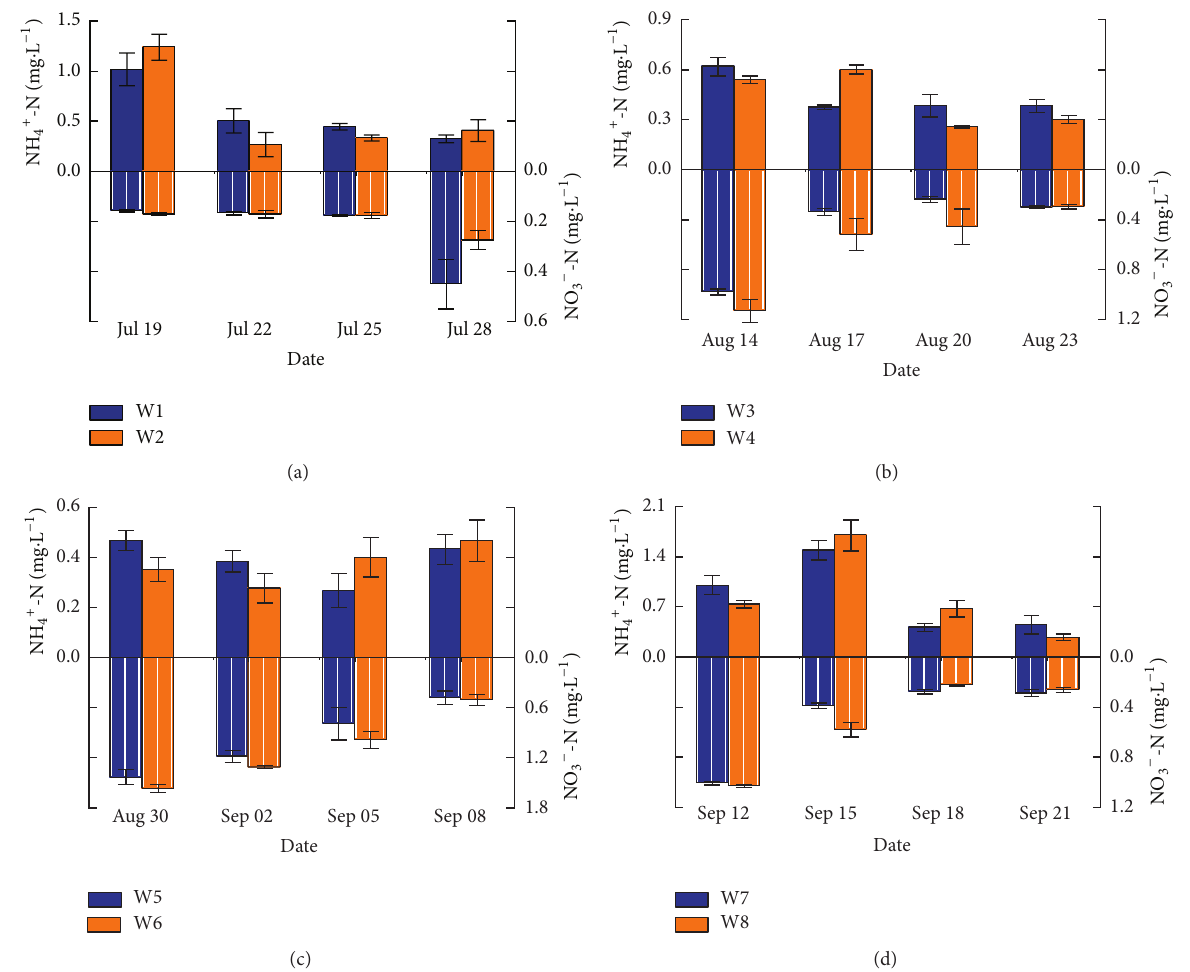
Figure 2: Dynamic changes of NH 4+ -N and NO 3− -N concentration in surface water. (a) Tillering stage. (b) Jointing-booting stage. (c) Heading-flowering stage. (d) Milking